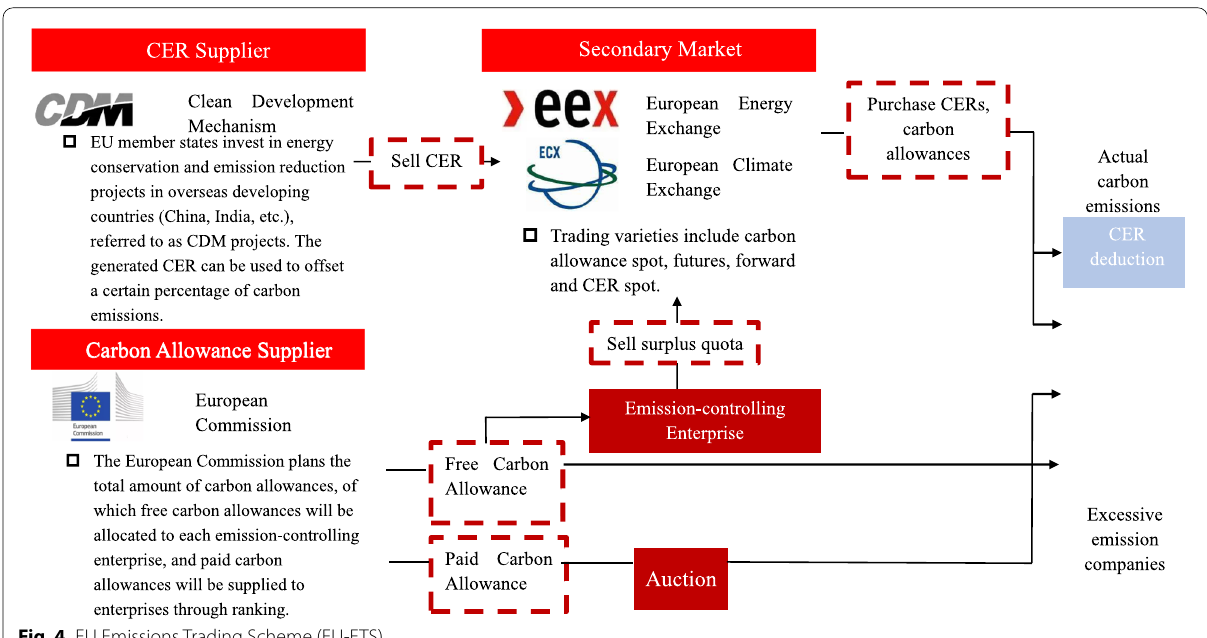
Fig. 4 EU Emissions Trading Scheme